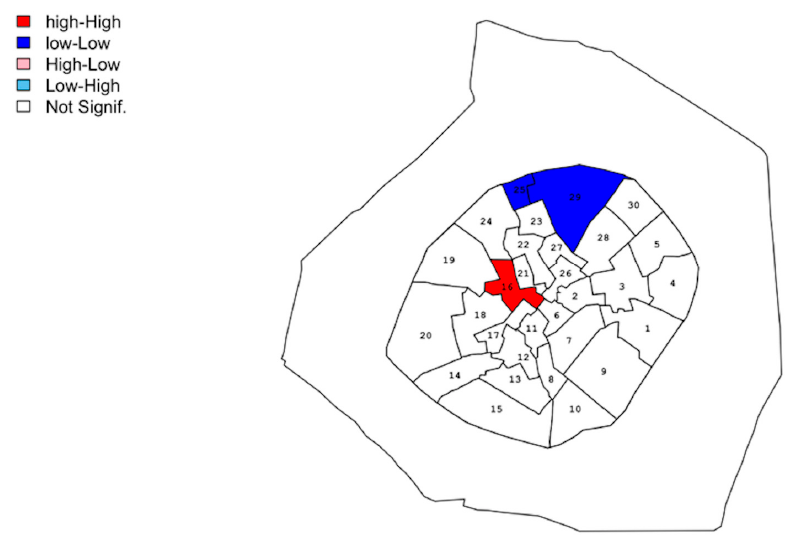
Figure 3. Position of clusters for all subjects and children in 1480. The distribution is the same for those two groups.